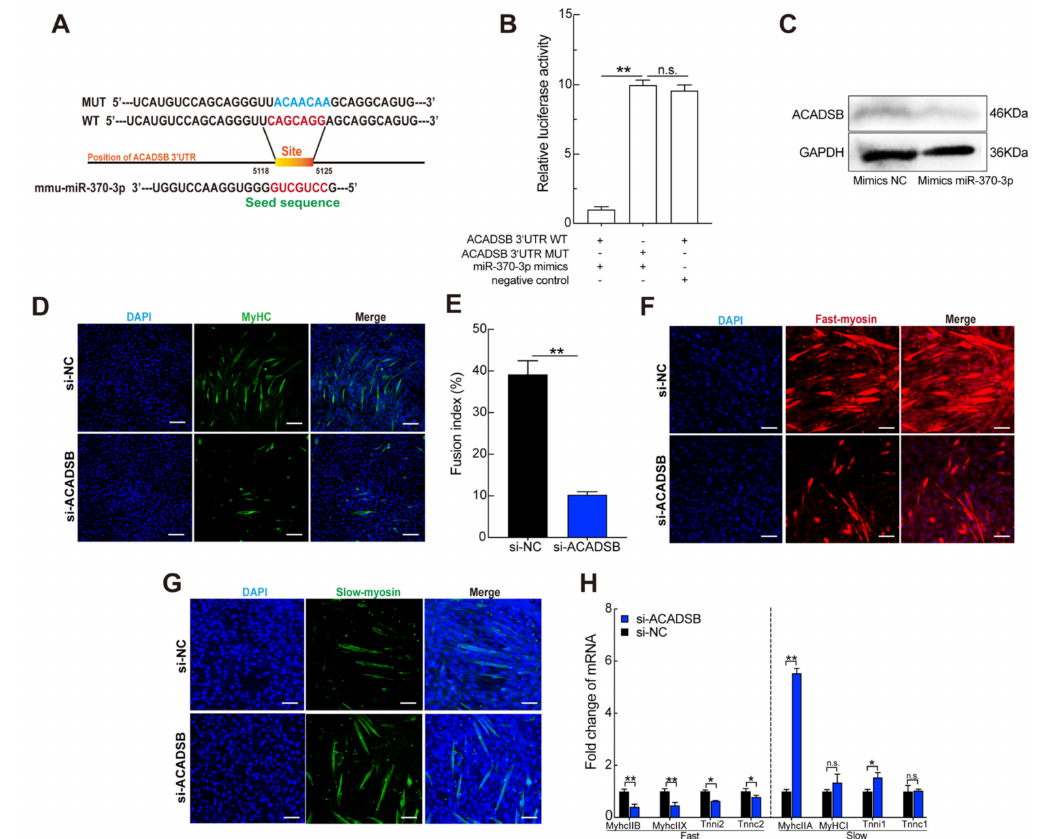
Figure 5. acyl-Coenzyme A dehydrogenase, short/branched chain (ACADSB) is a direct target of miR-370-3p during skeletal myogenesis. ( A ) Sequence alignment of miR-370-3p with 3 (cid:48) UTR of LACTB. ( B ) Luciferase assays revealed the suppressive effect of miR-351-5p on the activity of ACADSB. ( C ) ACADSB protein expression level in miR-370-p mimics and control cells. ( D , E ) After transfection for 8 d, C2C12 myoblast differentiation immunofluorescence was used to analyze MyHC, fusion index of myotube, and immunofluorescence was also used to analyze myosin-fast–positive ( F ) and myosin-slow–positive ( G ). ( H ) The expression levels of gene-related fast-twitch fibers and slow-twitch fibers were measured by qRT-PCR. Scale bars in ( D , F , G ) 50 µ m. Data are means ± SD. p -values are obtained from independent-samples t -tests. * p < 0.05, ** p <